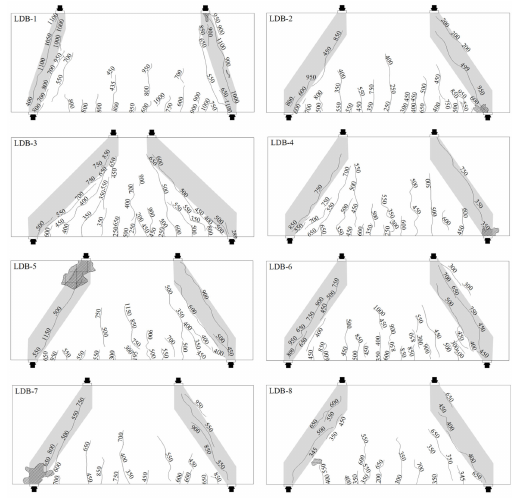
Figure 9. Crack patterns at